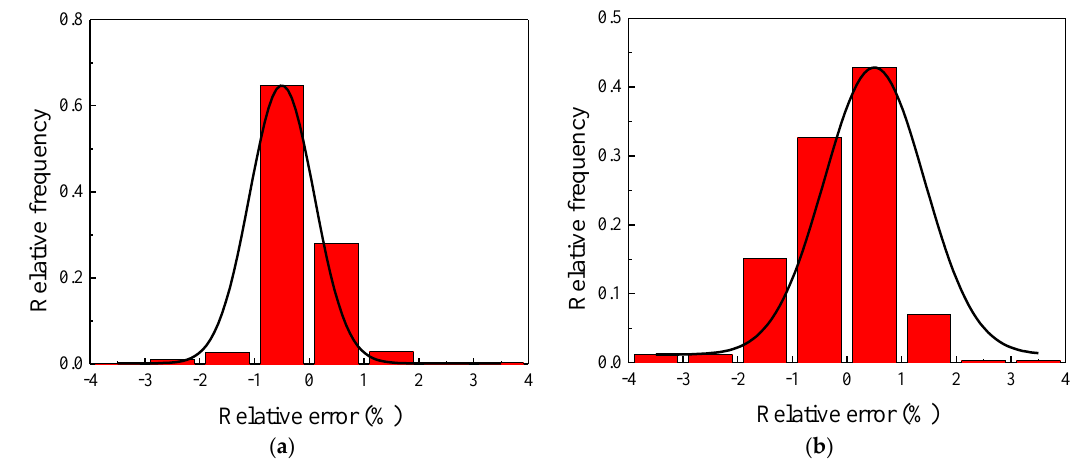
Figure 8. The relative error distributions of the predicted true stress corresponding to ( a ) the training points and ( b ) the test points.